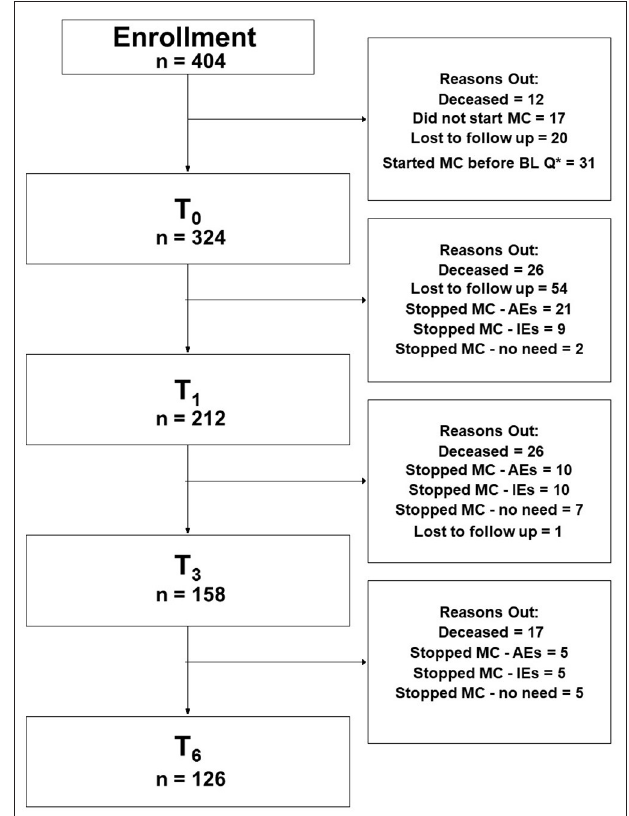
FIGURE 1 | Consort flowchart diagram. MC, medical cannabis; Q*, questionnaire; BL, baseline; AEs, adverse effects; IEs, ineffectiveness; T 0 , baseline time point (prior to MC treatment initiation); T 1 , 1-month follow-up; T 3 , 3-month follow-up; T 6 , 6-month follow-up; PP analyses refer to patients